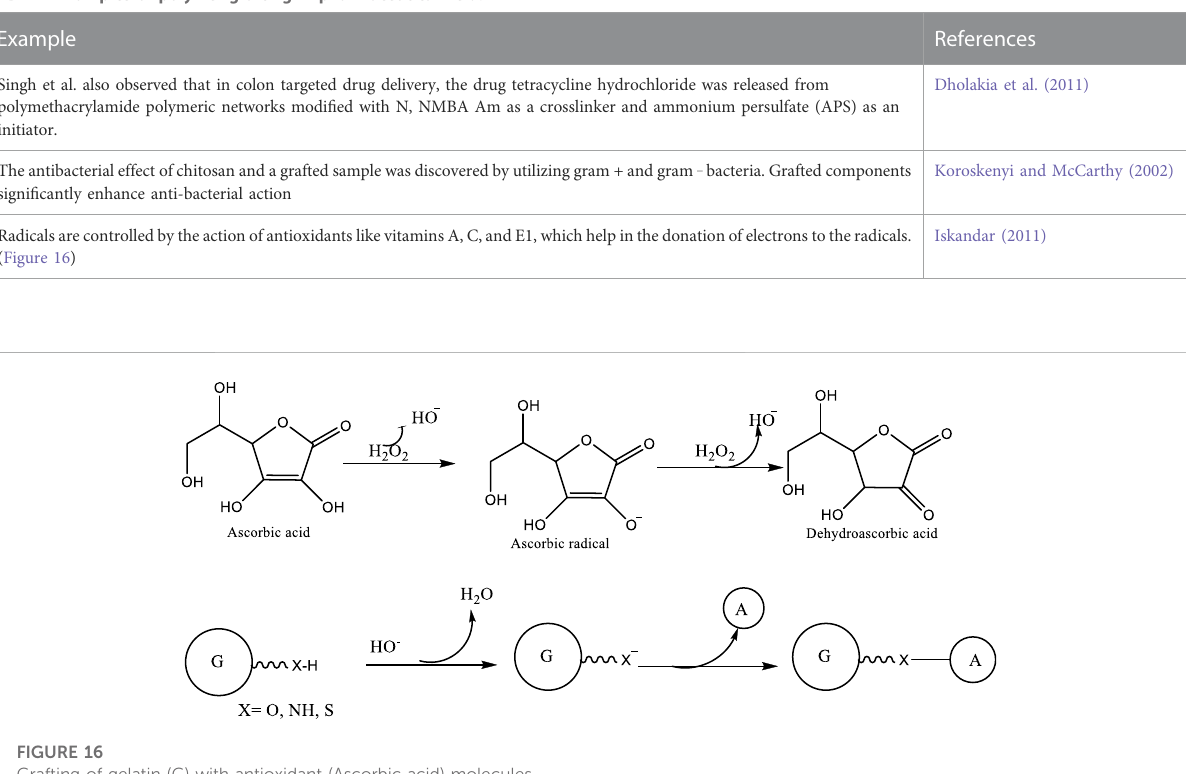
TABLE 2 Examples of polymer grafting in pharmaceutical fi